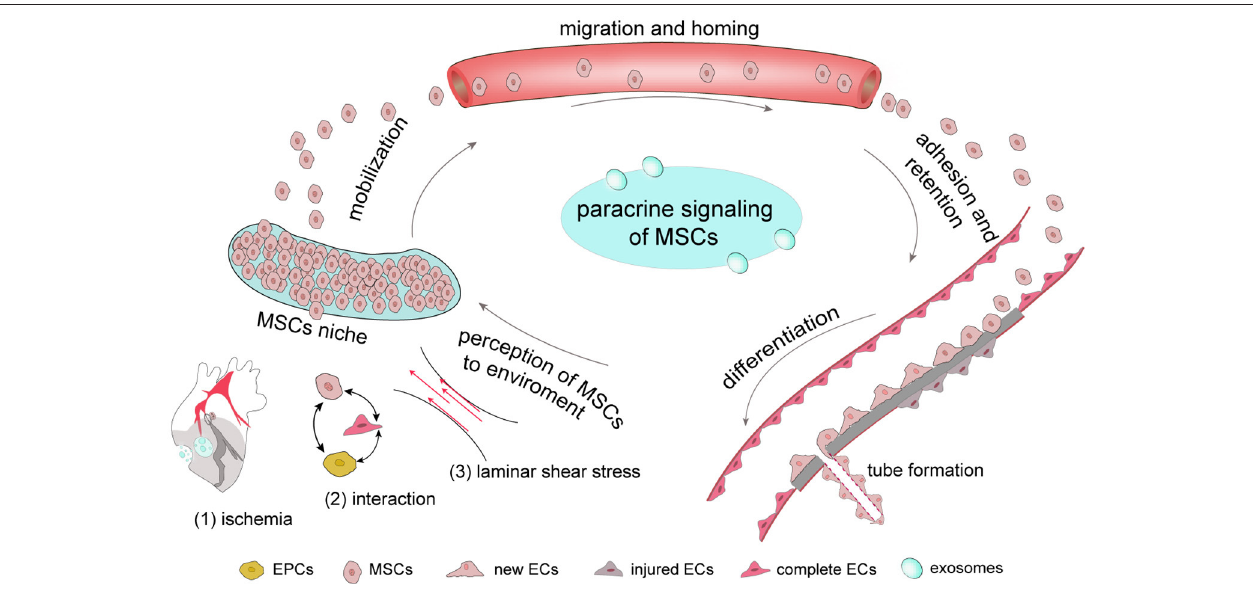
FIGURE 1 | The complete process by which MSCs respond to ischemia In general, MSCs are stored in their niches, which retain adult stem cell in a dormant state. Once tissue is damaged, signals, including those involve in ischemia-associated pathways, cell-cell interaction and stress mobilize stem cells to migrate from the stem-cell niche to damaged tissues, where they adhere, self-renew and differentiate. Once ischemia occurs, MSCs have the ability to secrete a number of growth factors through their paracrine function to promote new tube formation of ECs to provide new blood for ischemic